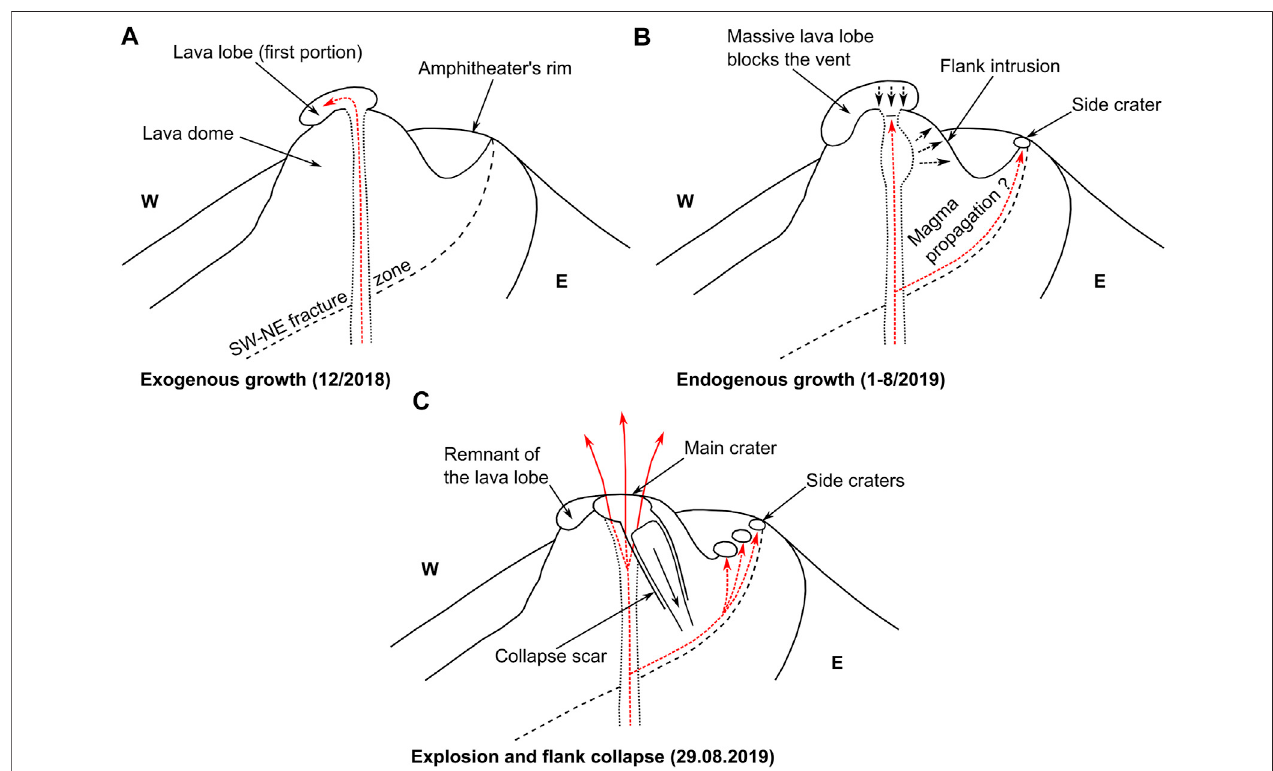
FIGURE13| Conceptualmodelofthe2018 – 2019eruptiveactivity (A) Theinitialstageofincreasederuptiveactivityand thedepositionofthenewlavalobe (B) The presence of the new lobe hindered the further extrusion of lava and induced endogenous swelling of the eastern fl ank (C) The explosive eruption and collapse of the eastern dome sector. The SW – NE lineament is shown with the black dashed line as a projection onto the decollement